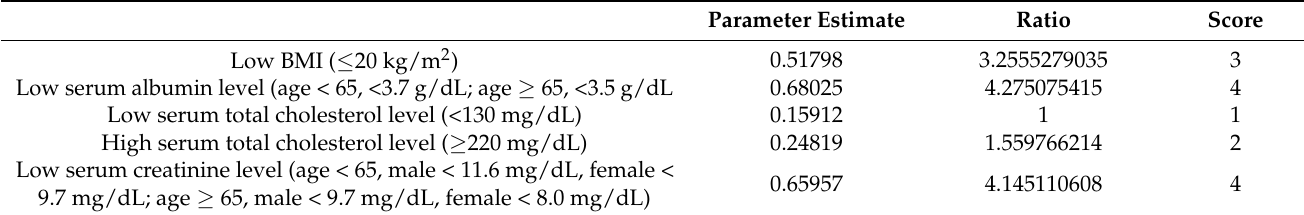
Table 1. Parameter estimates of the initial sarcopenia model and risk scores (Kanda E., et al. [12]). Parameter Estimate